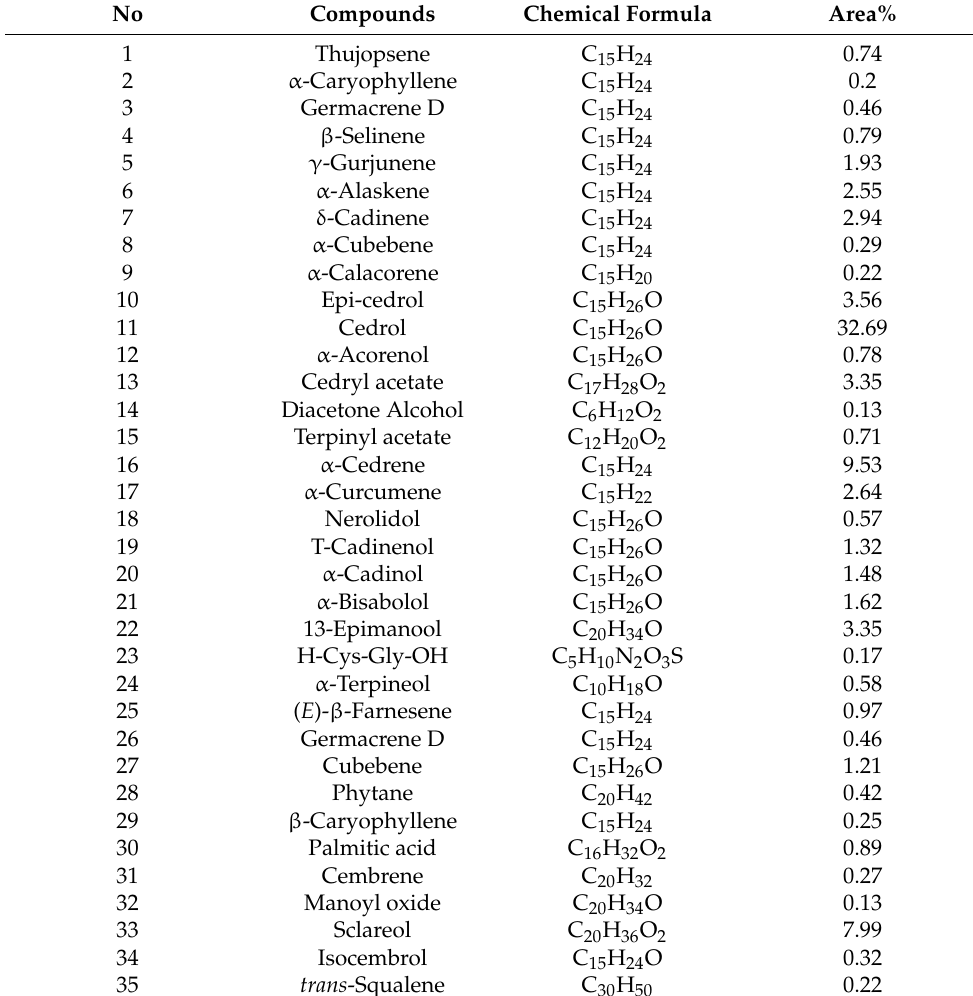
Table 1. Chemical composition of